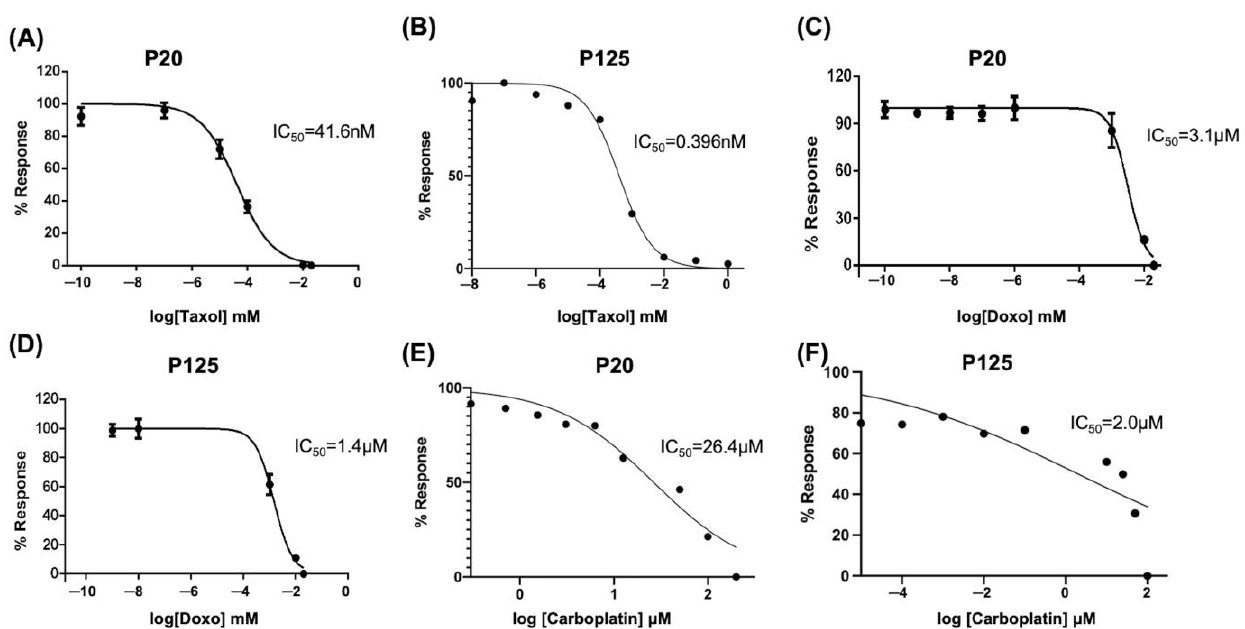
Figure 9. Chemosensitivity analysis of FE25 (p20) and FE25L (p125) cell lines. The IC 50 curve of taxol at passage 20 ( A ) and passage 125 ( B ); doxorubicin at passage 20 ( C ) and passage 125 ( D ); carboplatin at passage 20 ( E ) and passage 125 ( F ) FE25 cells. All experiments were repeated three times. Data represents mean ± standard deviation for three independent experiments.